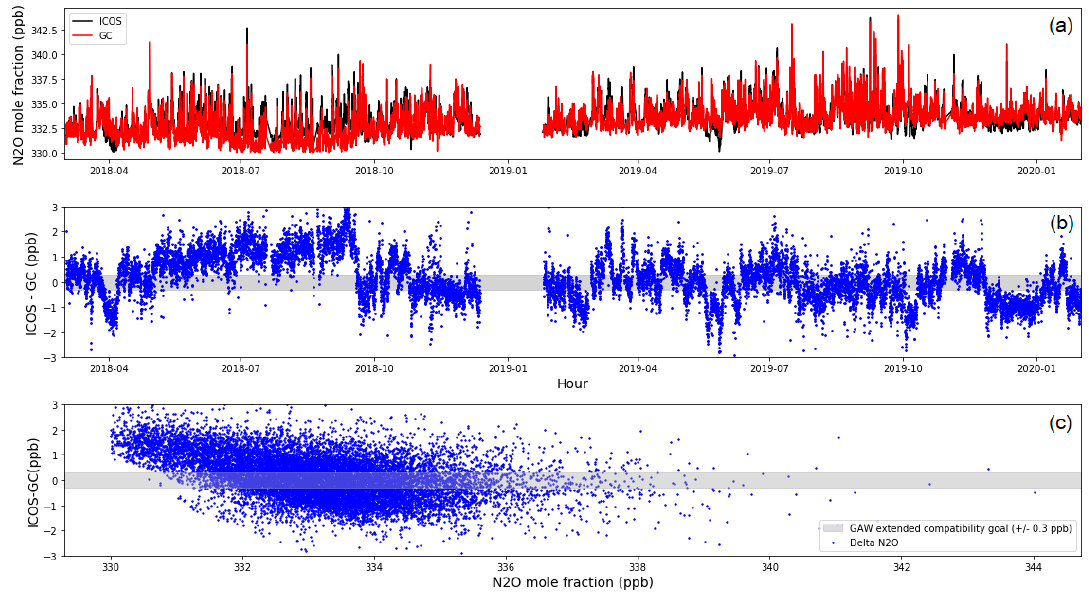
Figure 3. Comparison of N 2 O measured by OA-ICOS and the GC- µ ECD during 1 March 2018 to 1 January 2020. ( a ) Time series of OA-ICOS (black) and the GC- µ ECD (red) hourly mean, ( b ) time series of ∆ N 2 O (OA-ICOS minus the GC- µ ECD) over the same period, and ( c ) the ∆ N 2 O scatterplot according to the atmospheric N 2 O level measured by the GC- µ ECD. Note from 23 December 2018 to 25 January 2019, the OA-ICOS pump had a malfunction, and so, data were not compared during that period.